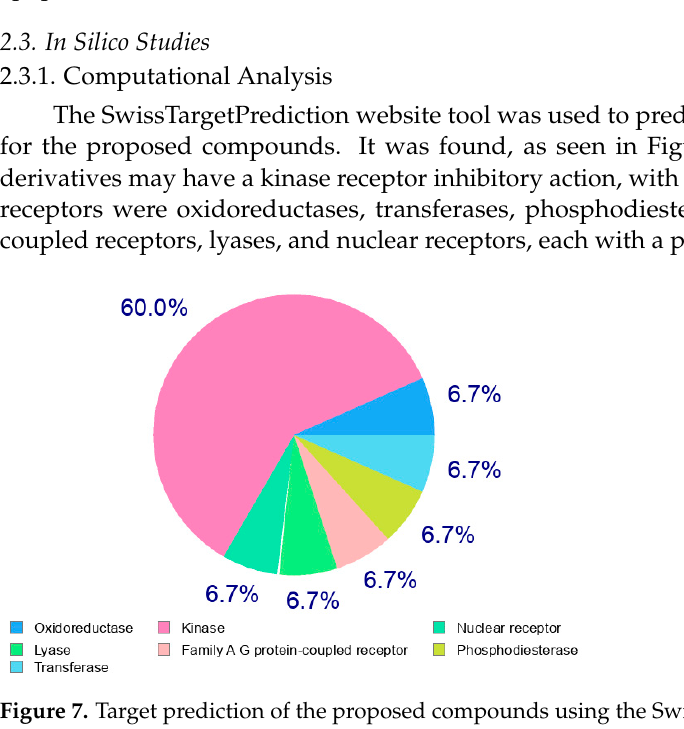
Figure 7. Target prediction of the proposed compounds using the SwissTargetPrediction Webtool.